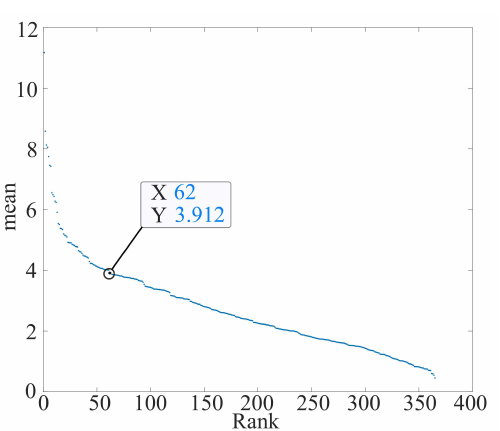
Figure 3. K-dist-mean